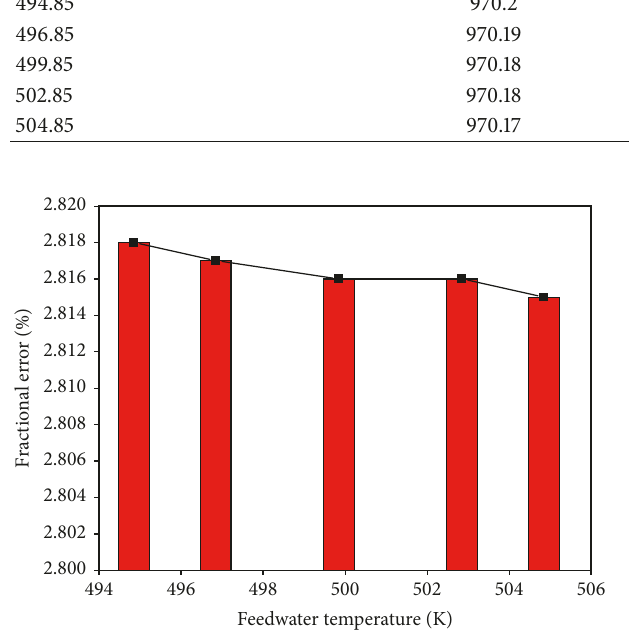
Figure 11: The influence of feedwater temperature on the fractional error between calculated and designed steam